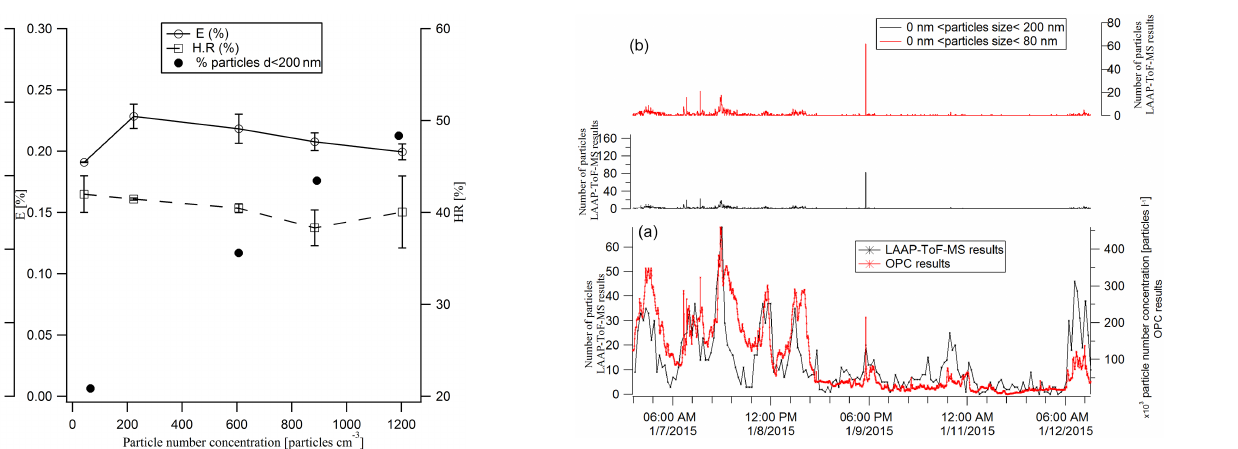
Many parameters such as particle number